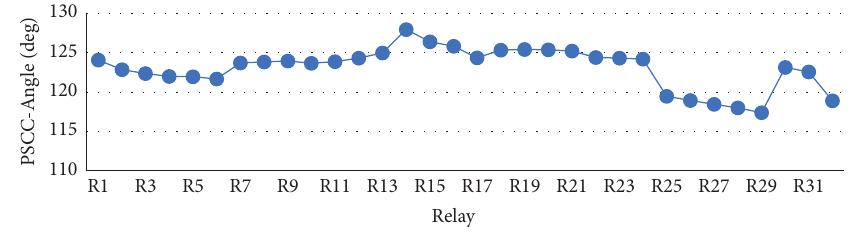
Figure 8: PCSS angle values at normal operation (case 1).